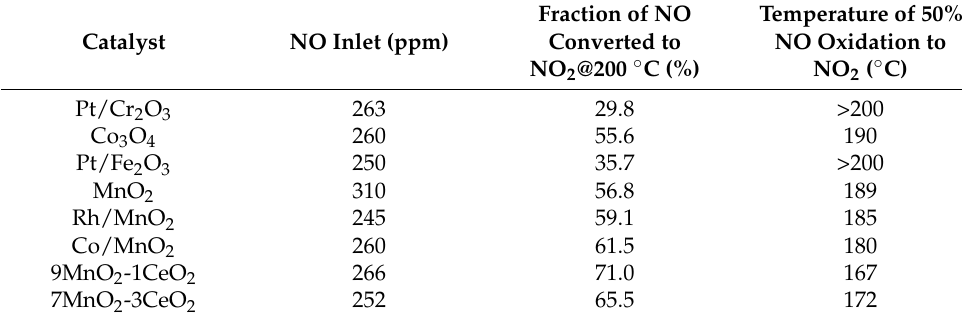
Table 4. Catalytic oxidation activity of various